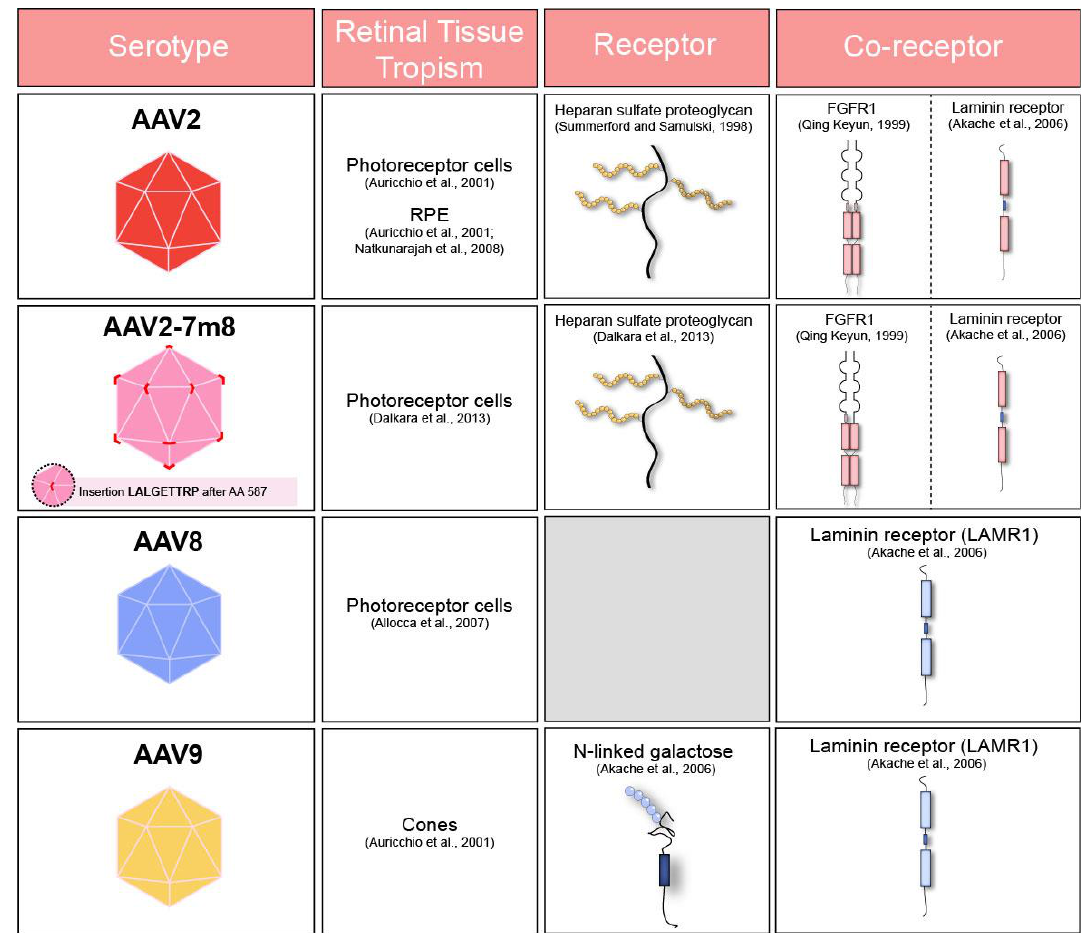
Figure 1. Table summarizing adeno-associated virus (AAV) receptors, co-receptors and cell tropism of commonly used serotypes after subretinal administration in murine [23–25] and primate retina [26]. FGFR1: Fibroblast Growth Factor Receptor 1. LAMR1: Laminin Receptor 1.